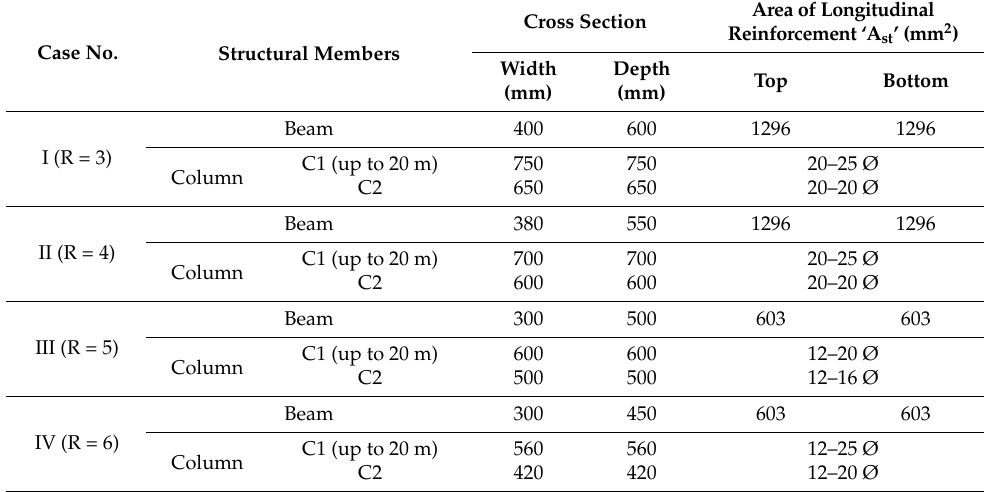
Table 3. Structural details of the unsymmetrical building, with Case I (R = 3), Case II (R = 4), Case III (R = 5), Case IV (R =